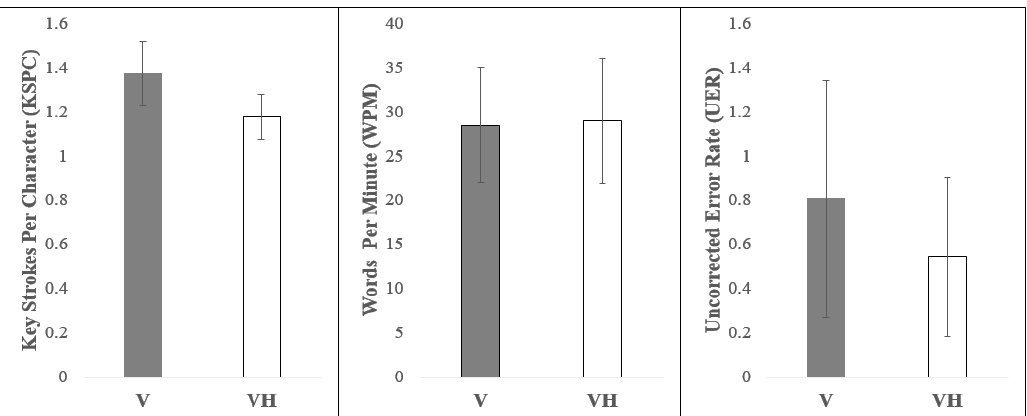
Figure 10. Typing performance results measured by a user study across two conditions V and VH. Key strokes per character (KSPC), words per minute (WPM), and uncorrected error rate (UER) were interpreted as typing efficiency, speed, and accuracy on the 10.1 inch touchscreen. The bars represent means and standard deviations of each metric for the two conditions. A lower value meant better performance except for WPM.